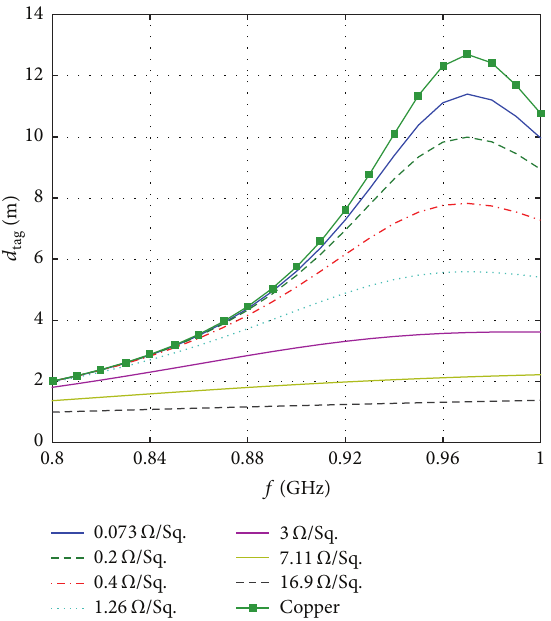
Figure 4: Simulated attainable read range of the